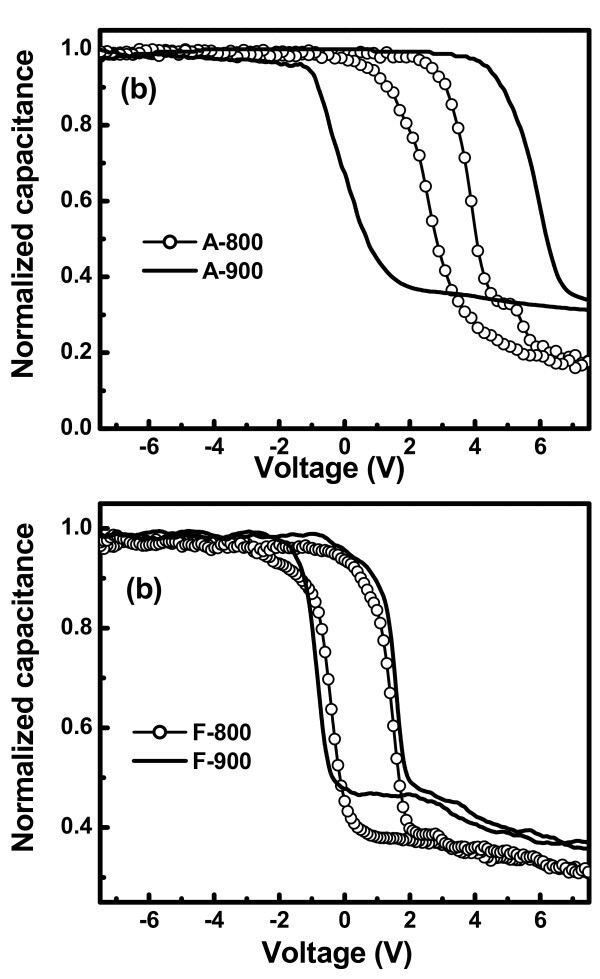
High-frequency (100 kHz) C-V characteristics of MOS capacitor with Ge nanocrystals embedded in high-k (a) Al2O3 and (b) HfO2 matrix.